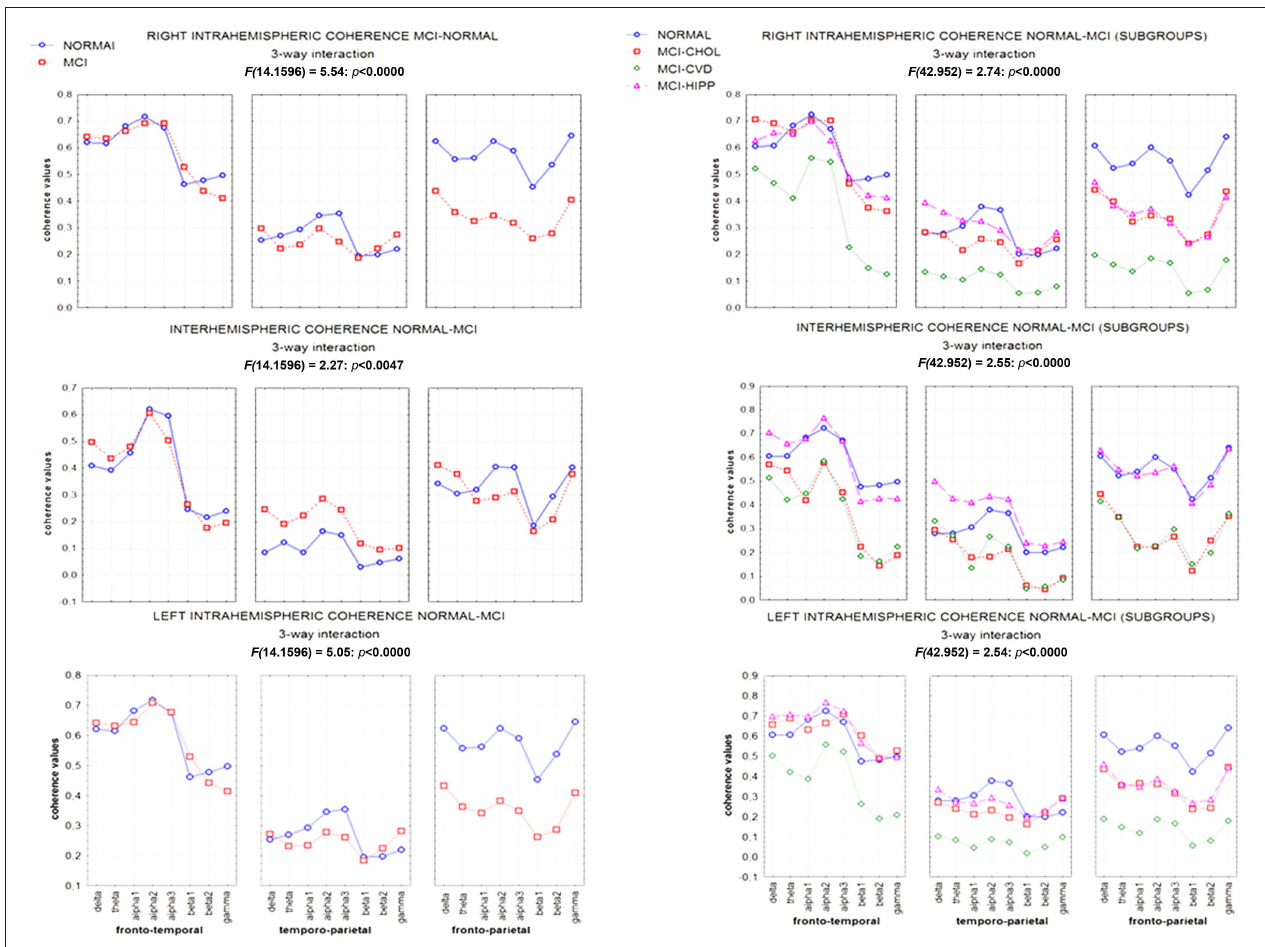
FiGurE 5 | ANOVA statistical results. On the left part of the figure statistical ANOVA results of the first session analysis (normal-MCI whole group); on the right part of the figure statistical ANOVA results of the second session analysis (MCI subgroups-matched normal old group; (MCI-CHOL, MCI with greater cholinergic damage, MCI-CVD, MCI with greater cerebrovascular damage; MCI-HIPP, MCI with greater hippocampal atrophy; see Moretti et al.,